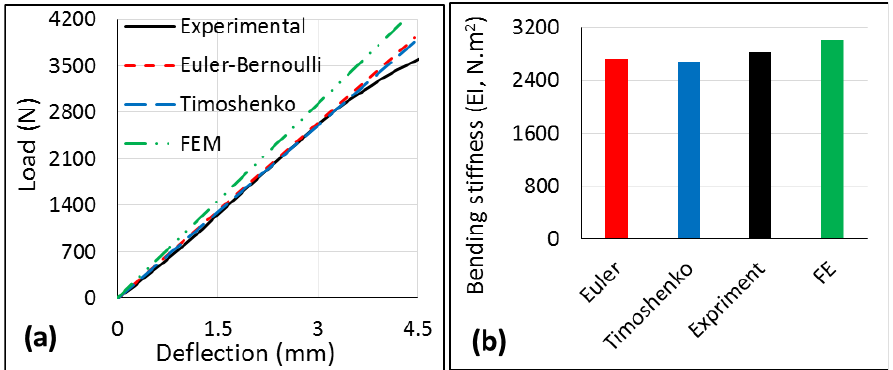
Figure 10. Comparison of ( a ) load–deflection curve and ( b ) bending stiffness of sandwich beams under bending load as shown in Figure 3d based on different models.